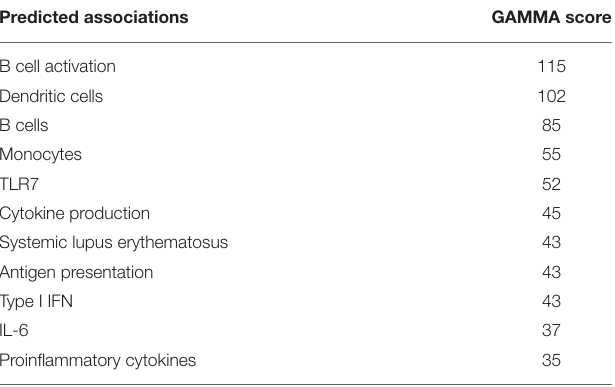
TABLE 1 | Global meta-analysis (GAMMA 25 ) scores predicted associations with CXorf21 based compilation of publicly available microarray data and literature search.